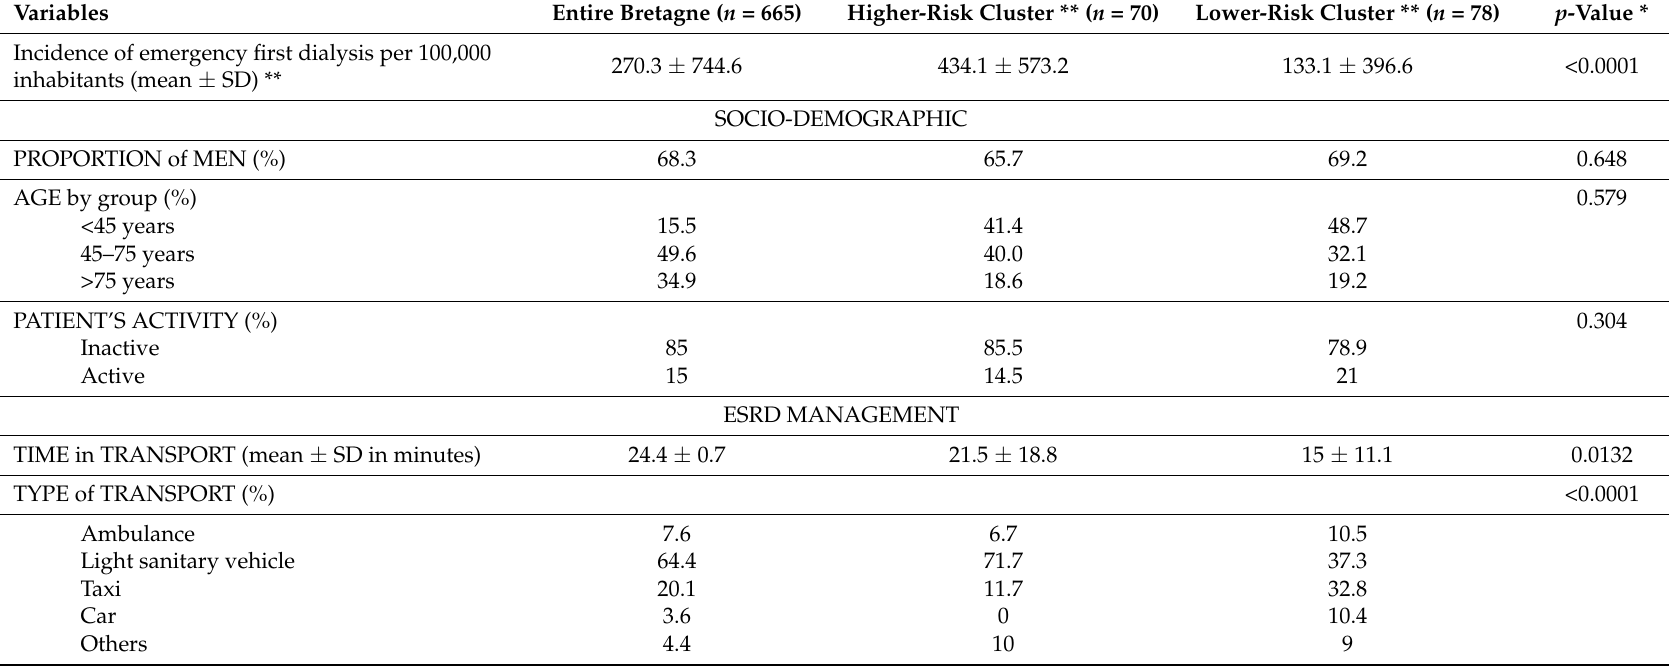
Table 2. Description of the socio-economic characteristics and ESRD management characteristics of the patients with ESRD who started the first dialysis in emergency in the entire Bretagne region and within the higher-risk and lower-risk clusters (no. of patients = 665).